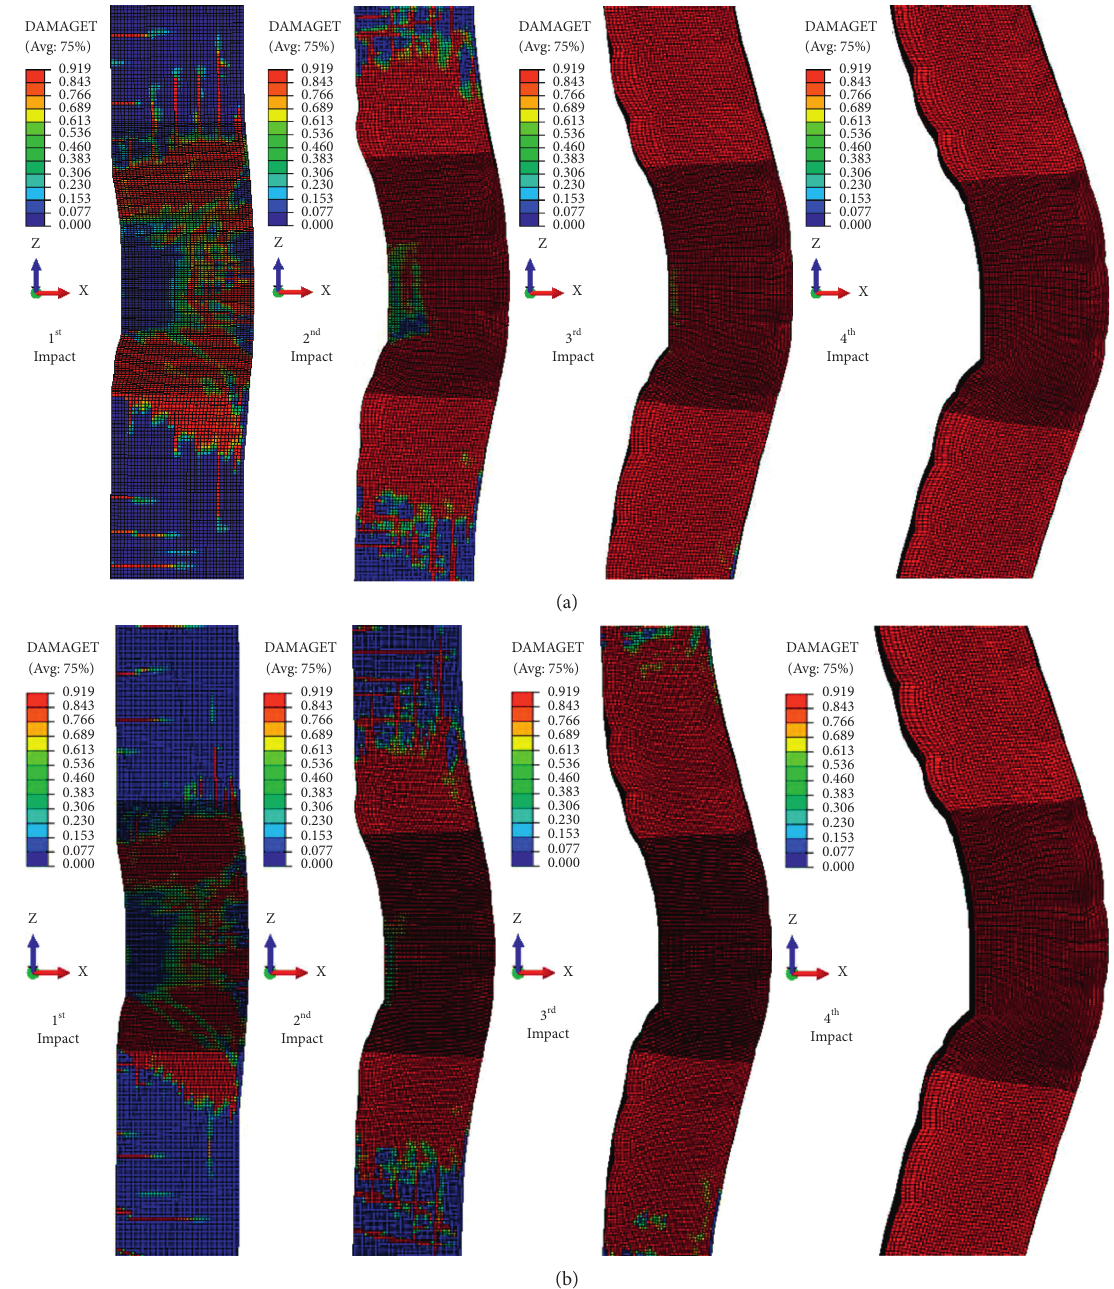
Figure 17: Concrete tensile damage subjected to repeated impact: (a) without CFRP confinement and (b) with CFRP